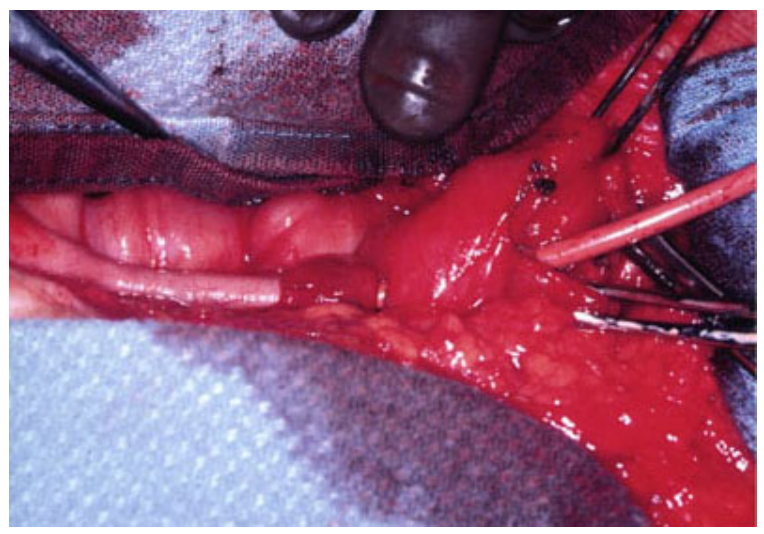
FIGURE 7 . Mitofanoff catheterizable stoma: appendix implanted into augmented bladder to provide continent catheterizable access to